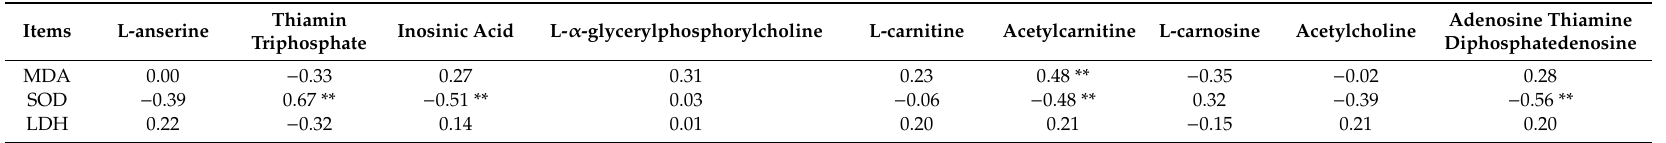
Table 3. Correlation among metabolites content, MDA, SOD, and LDH of longissimus dorsi muscle in finishing pigs (Pearson’s linear regression test, n =